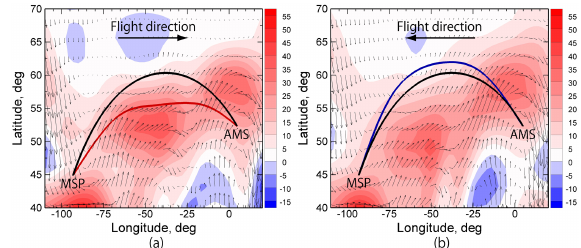
Figure 14. Trajectories for the time-optimal (red and blue lines) and great circle cases (black lines) between MSP and AMS. The contours show the zonal wind speed ( u in ms − 1 ); arrows (black) p u 2 + v 2 ) and direction. (a) The eastbound show the wind speed ( flight from MSP to AMS with the wind field at h = 8839m at 21:35:00UTC. (b) The westbound flight from AMS to MSP with the wind field at h = 10002m at 12:50:00UTC.